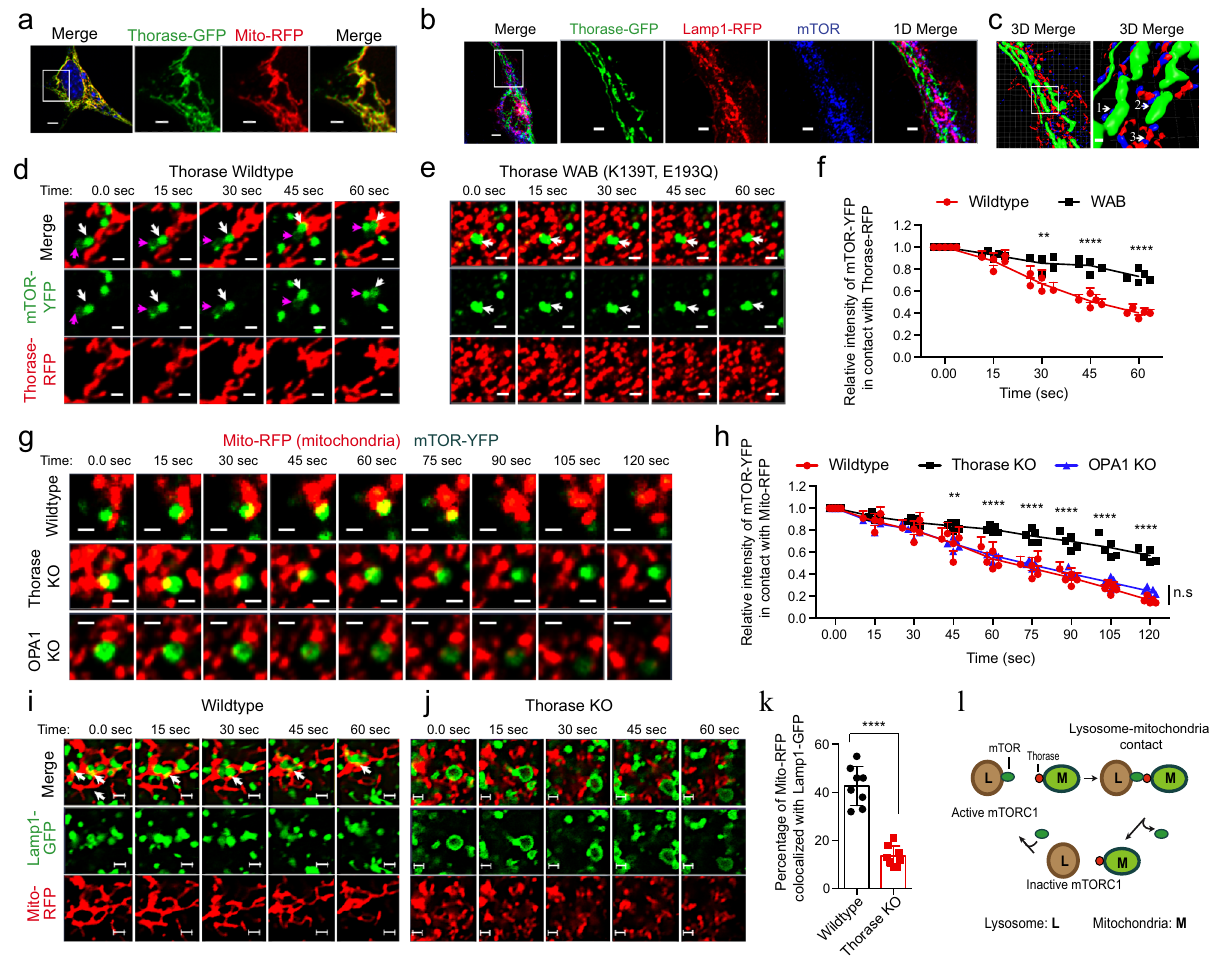
Fig. 4 | Thorase interacts with mTOR at the lysosome-mitochondria contacts. a Representative images of mouse embryonic fi broblasts (MEF) co-expressing Thorase-GFP (green) and mito-RFP (mitochondria, red). Scale bars are 5 μ m (low), 2 μ m (high) magni fi cation. b , c Representative 2D and 3D Images of mouse embryonic fi broblasts (MEF) showing colocalization of Thorase and mTOR at the lysosome(Lamp1).Scalebarsare5 μ m(low),2 μ m(higher)magni fi cation.Different interactions, 1 (Thorase-mTOR), 2 (Thorase-mTOR-Lamp1) and 3 (mTOR-Lamp1) are indicated. d Representative images oftime series of colocalization of wild type Thorase-RFP(red)withmTOR-YFP(green).TheinteractionsofThorasewithmTOR vesicles (white arrow) results in diffusion or reduction of mTOR labels. Meanwhile mTOR labeling increases in vesicle (purple arrow) that is not in contact with Thorase-vesicles. Scale bars are 1 μ m. e Representative images of time series of colocalization of Thorase-RFP WAB mutant (red) with mTOR-YFP (green). Scale